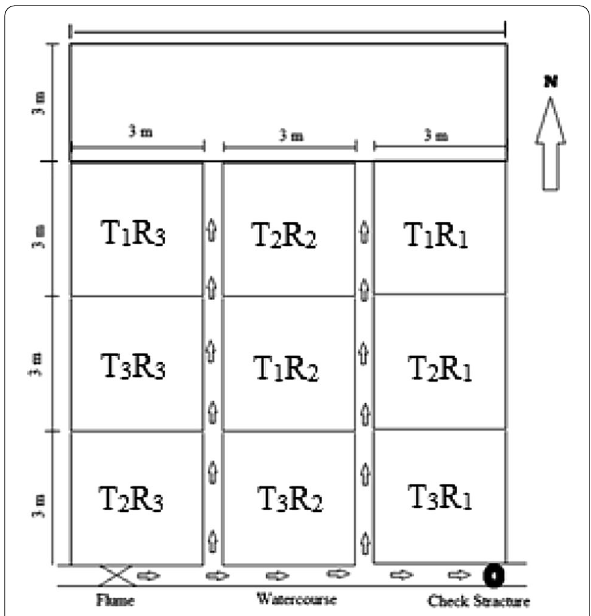
Fig. 1 Layout of experimental plot and